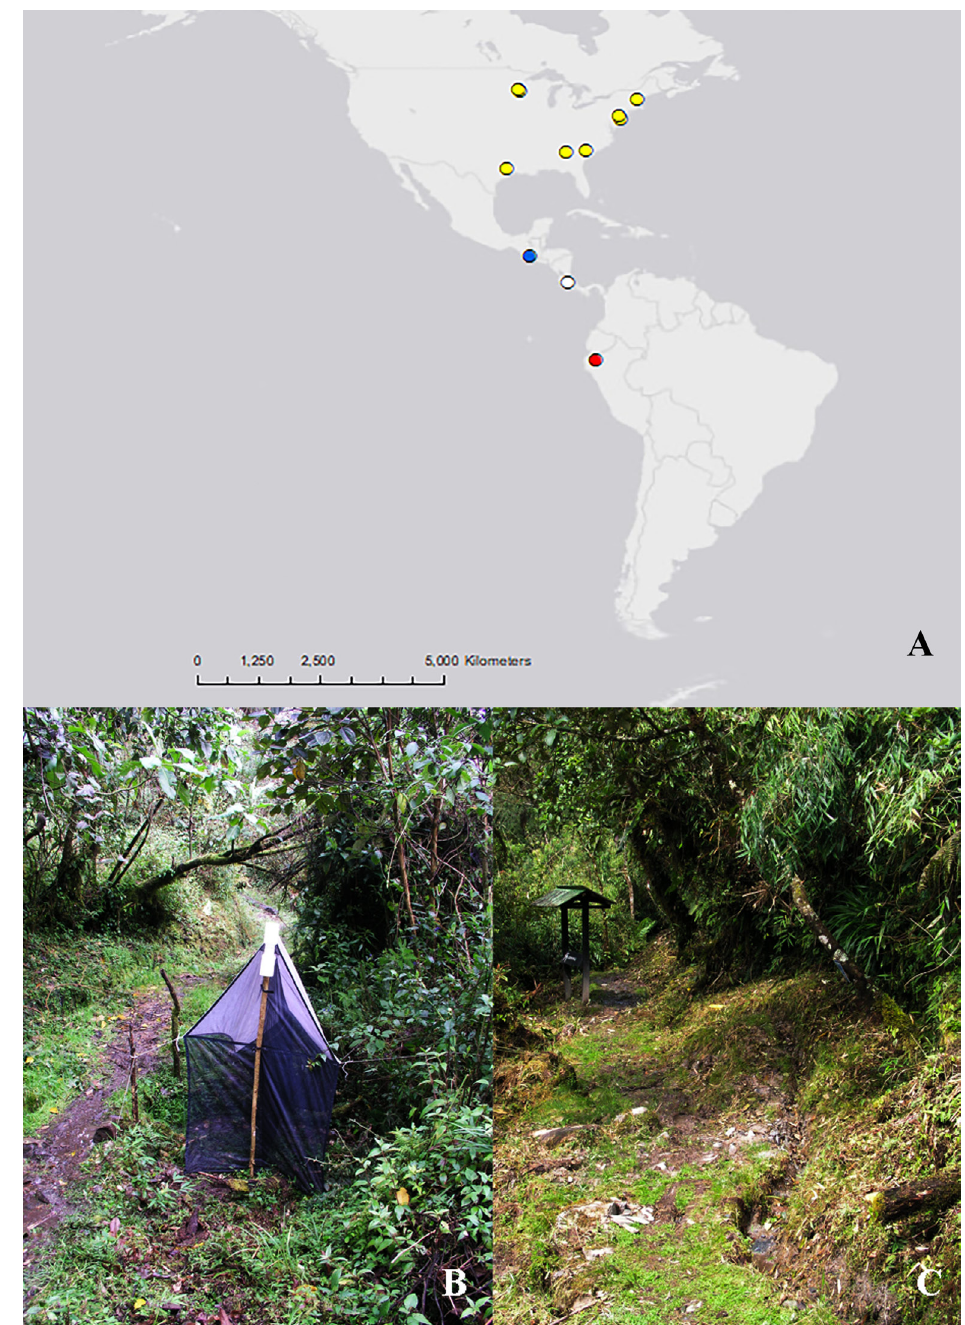
Fig. 8 . Distribution and habitats of Nanium . A . Distribution of Nanium species (blue – N. atitlanensis Reshchikov & Sääksjärvi sp. nov.; yellow – N. capitatum Townes, 1967; white – Costa Rican species ( N. huberthi Gauld, 1997, N. mairenai Gauld, 1997, N. nogueri Gauld, 1997, N. oriasi Gauld, 1997); red – N. medianum Reshchikov & Sääksjärvi sp. nov.). B . Malaise trap and type locality of N. medianum sp. nov. on the trail Bosque Nublado, Cajanuma, Podocarpus Parque Nacional, Ecuador. C . Trail Oso de Anteojos near the type locality of N. medianum sp. nov., Podocarpus Parque Nacional, Ecuador, where the paratype specimen was captured in a yellow pan